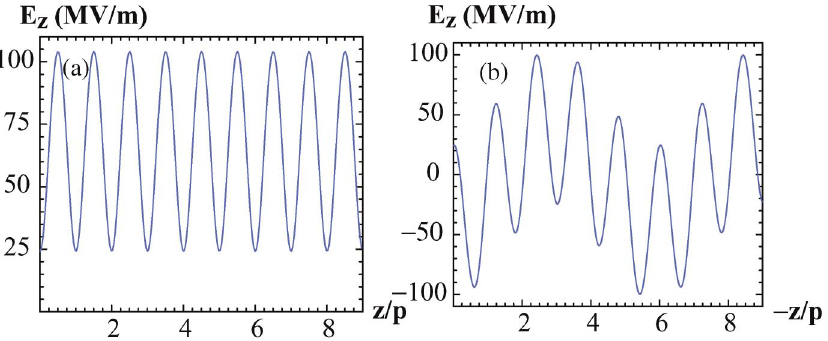
FIG. 3. (Color) The longitudinal electric field seen by a test particle moving with the rf wave on crest (a), and by one moving (at the speed of light) against the wave